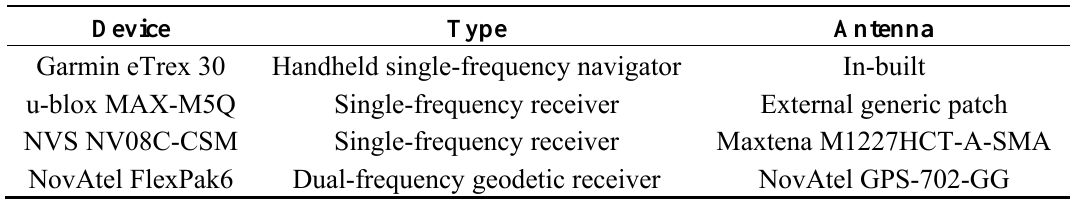
Table 5. The tested GNSS devices.